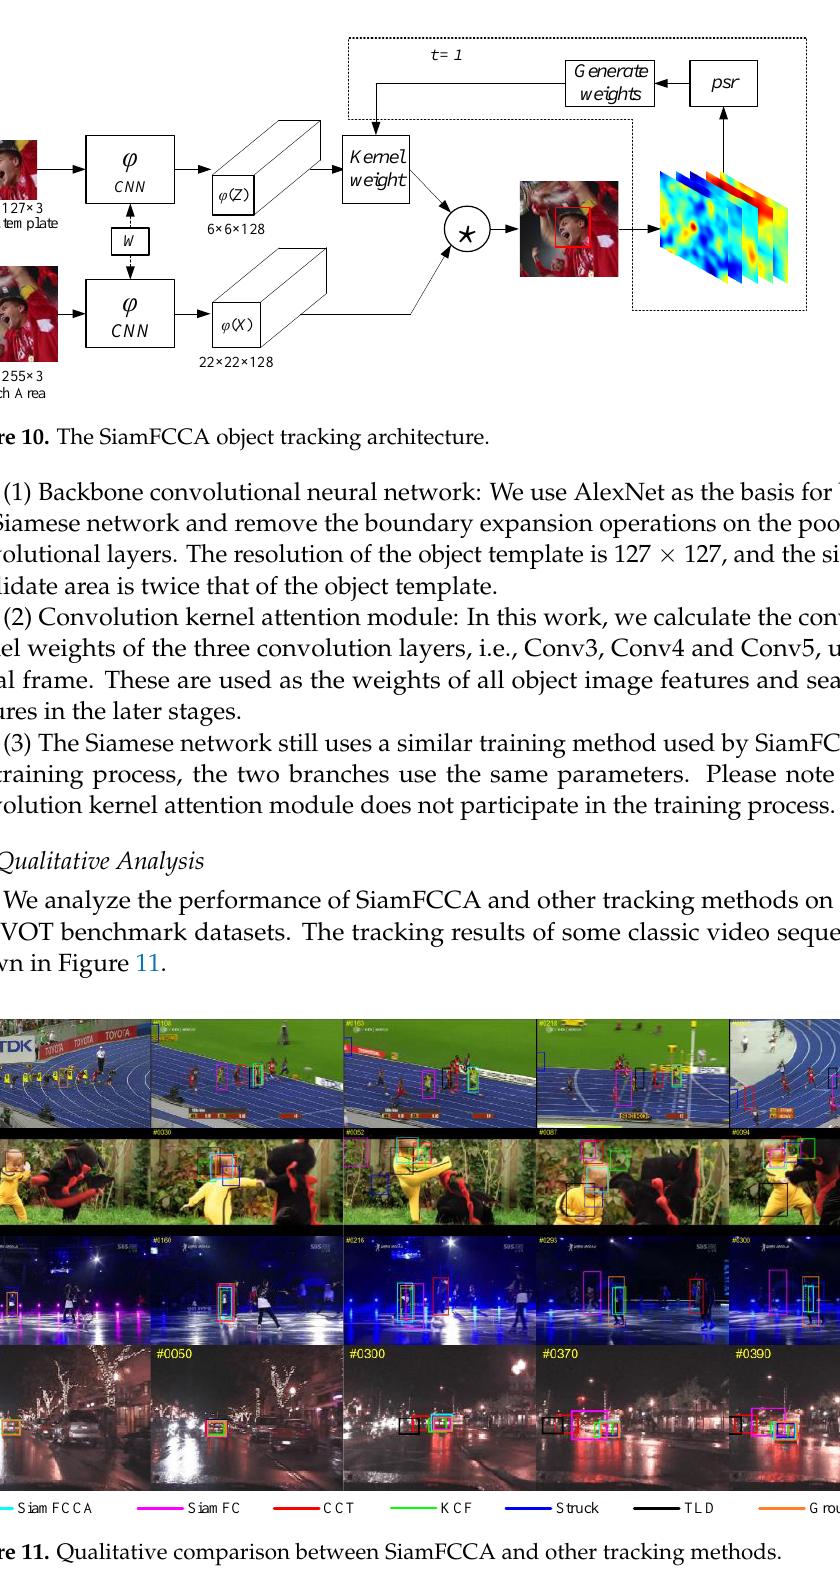
Figure 11. Qualitative comparison between SiamFCCA and other tracking